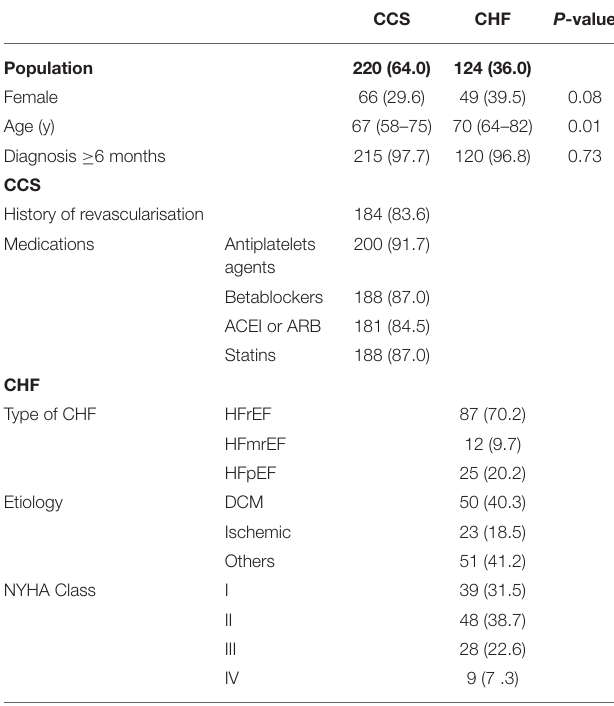
TABLE 1 | Population characteristics according to cardiovascular